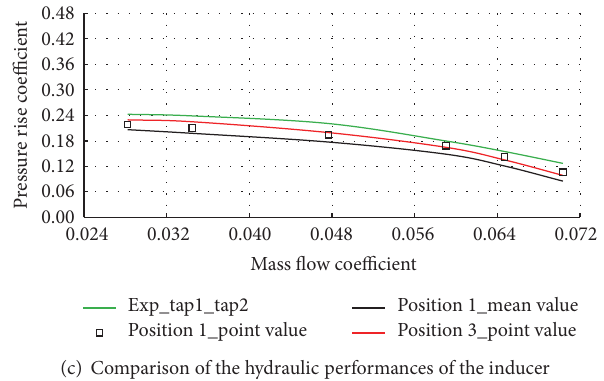
(a) Comparison of turbulence models and boundary conditions at the flow coefficient of B = 0.05903